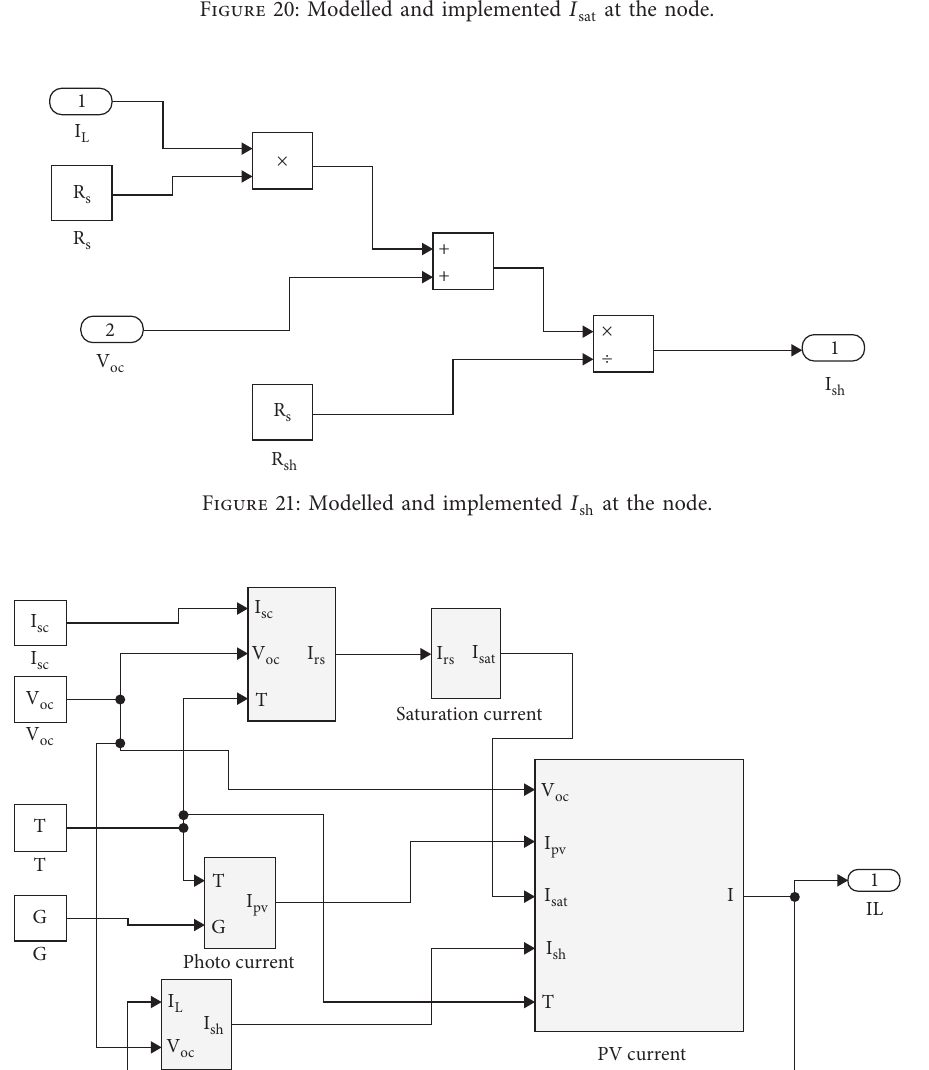
Figure 20: Modelled and implemented I